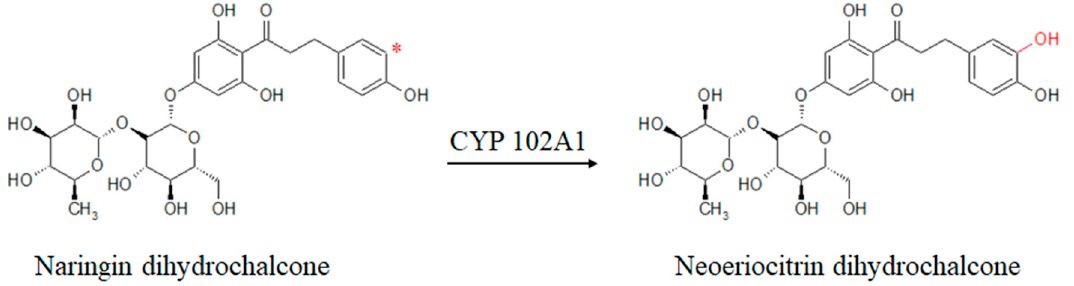
Figure 1. Chemical structures of naringin DC and neoeriocitrin DC. The conversion of the substrate, naringin DC, to its corresponding product, neoeriocitrin DC, is catalyzed by CYP102A1 in the presence of NADPH. An enzymatic reaction site on naringin DC is marked by a star.